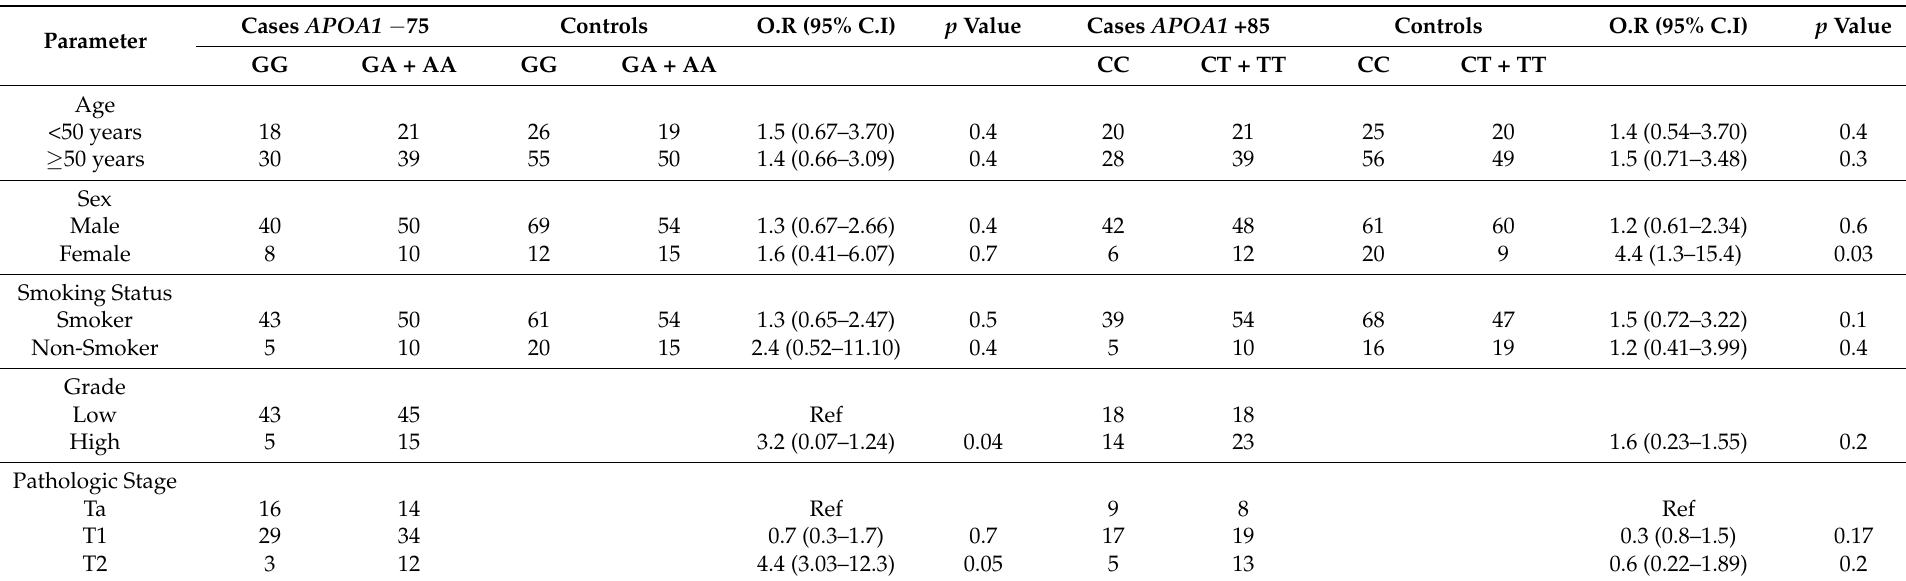
Table 2. APOA1 gene 75 G>A and +83 C>T polymorphic sequence variations in different clinical